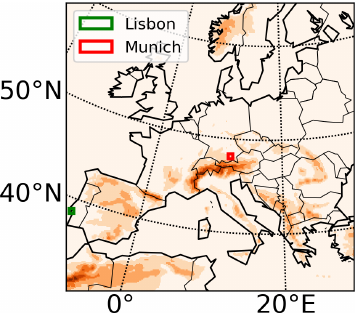
Figure 1. CRCM5 topography.